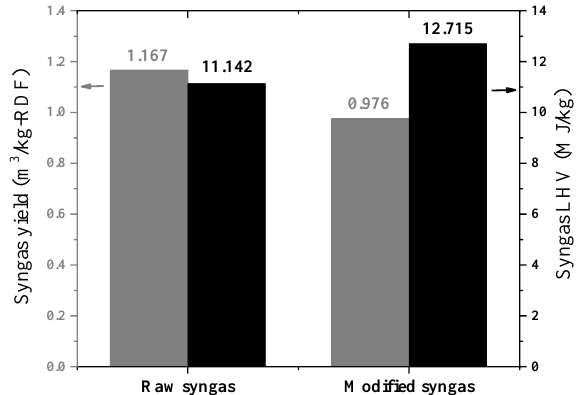
Figure 6. LHV and yield of the raw syngas and modified syngas.